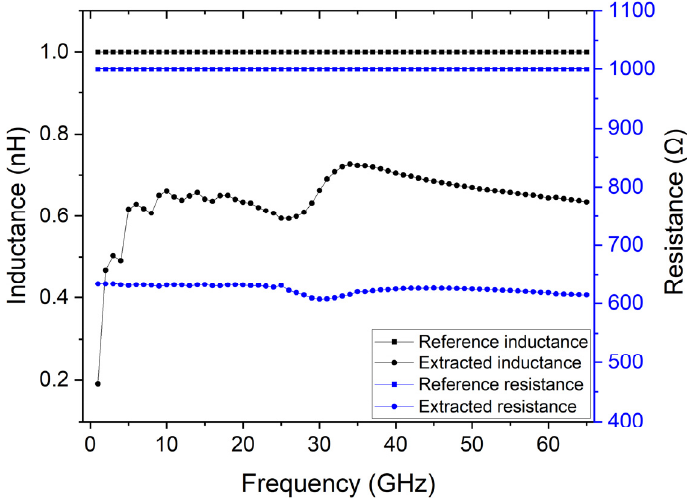
Figure 2. Comparison of extracted inductance and resistance parameters of the lumped model when 20 nm thick gold contacts are used, and the expected reference values.